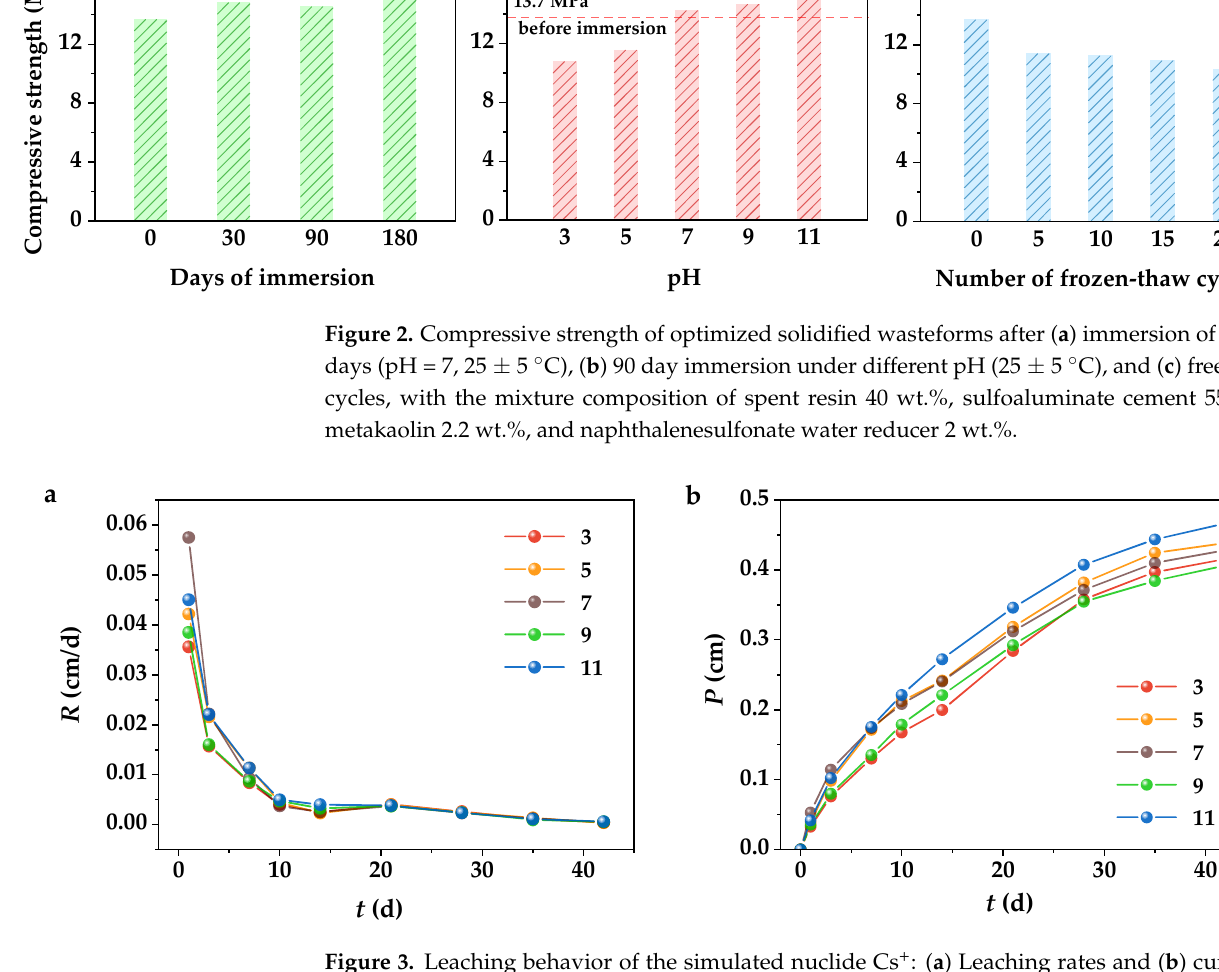
Figure 3. Leaching behavior of the simulated nuclide Cs + : ( a ) Leaching rates and ( b ) cumulative leaching fractions; V L = 1.6 L, V L /F = 13.35, 25 ± 5 °C.